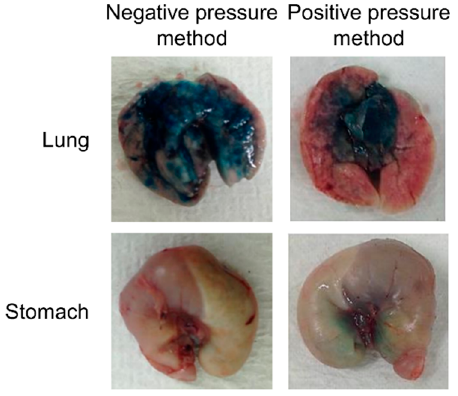
Figure 3. Macroscopic features of lungs and stomachs after pulmonary administration using the negative pressure method and the positive pressure method.